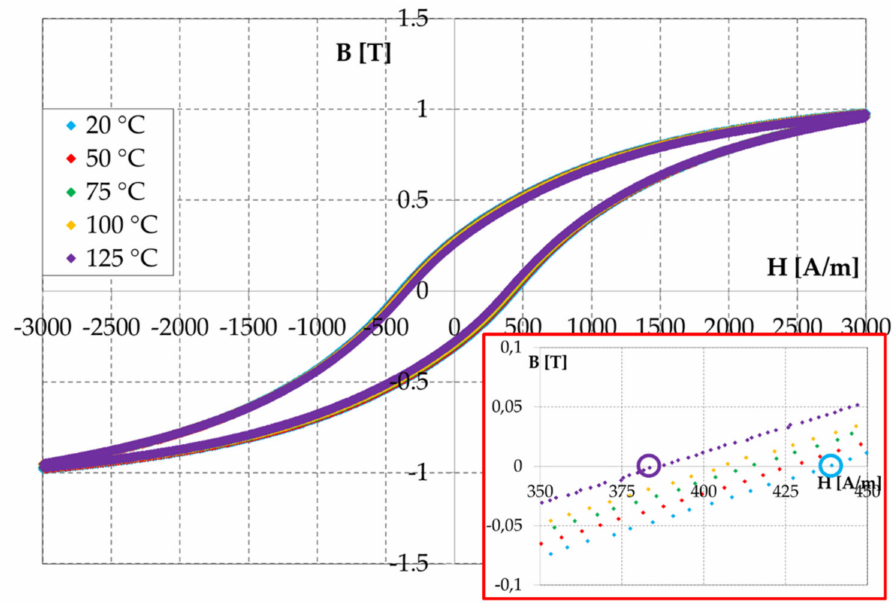
Figure 11. Hysteresis cycles at different temperatures of SMC sample E 0.2-500 for different